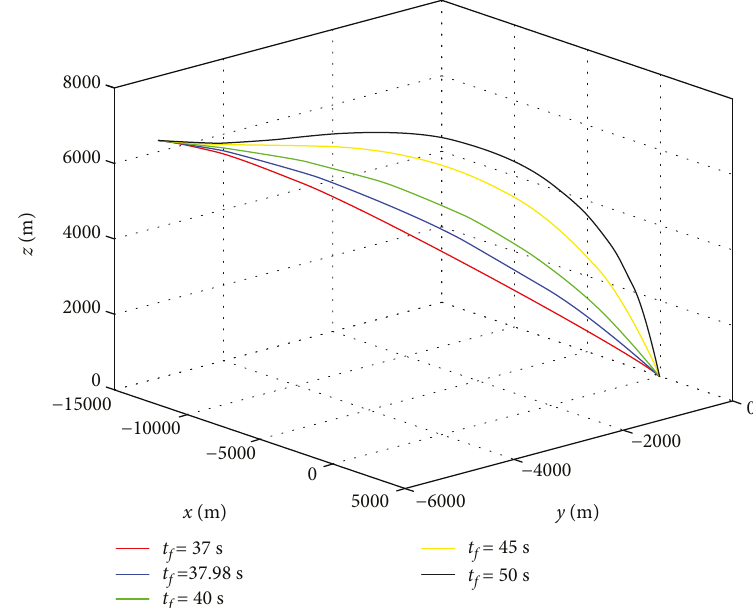
Figure 2: Missile 1 trajectories with di ff erent fl ight